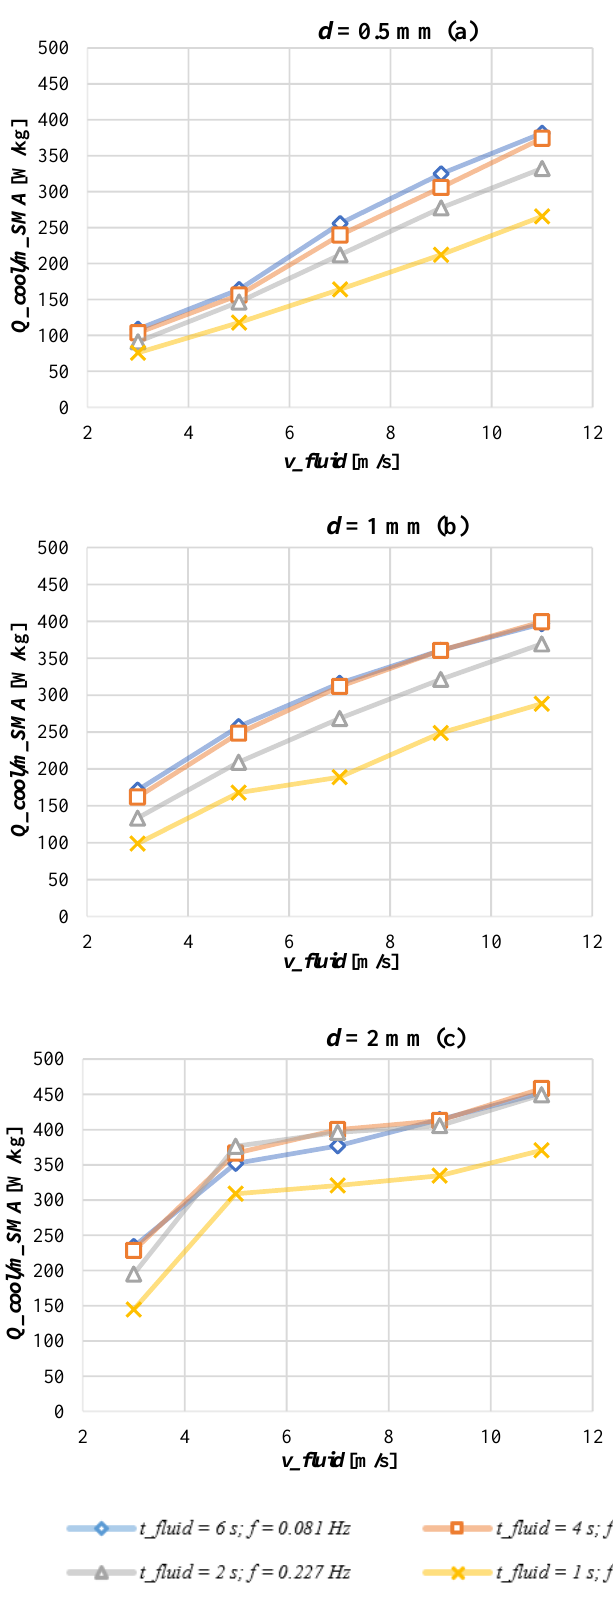
Figure 9. Cooling power per mass unit as function of the velocity parametrized for the convective heat transfer process when the distance between two wires is: ( a ) 0.5 mm; ( b ) 1.0 mm; ( c ) 2.0